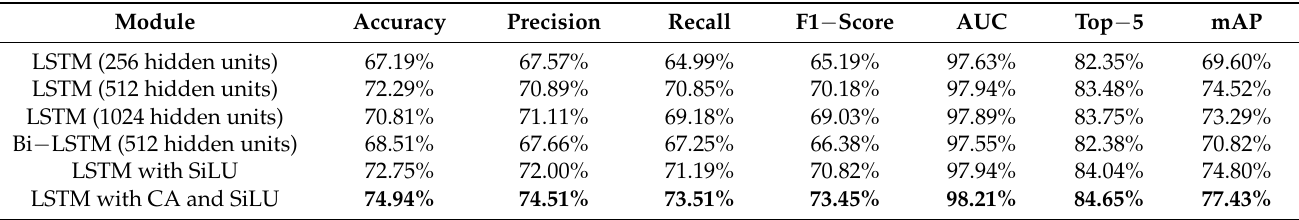
Table 5. Ablation study of the proposed method. The coordinate attention and SiLU module were disassembled in the ablation experiment. The best results are shown in bold